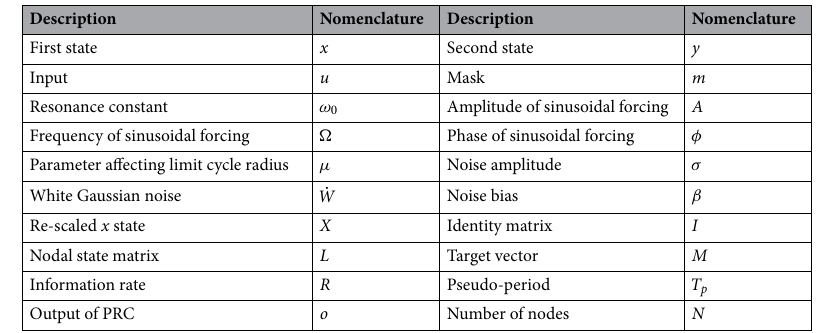
Table 1. List of parameters, states, and